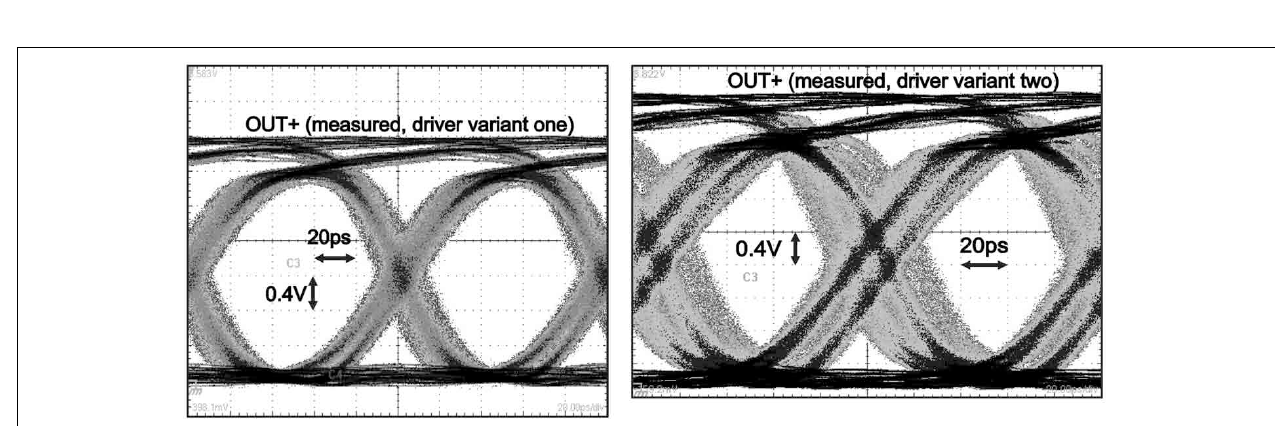
FIGURE 10 | Measured eye diagrams at 10Gb/s for 100mV pp input voltage difference of driver variant one (left side) and driver variant two (right side).